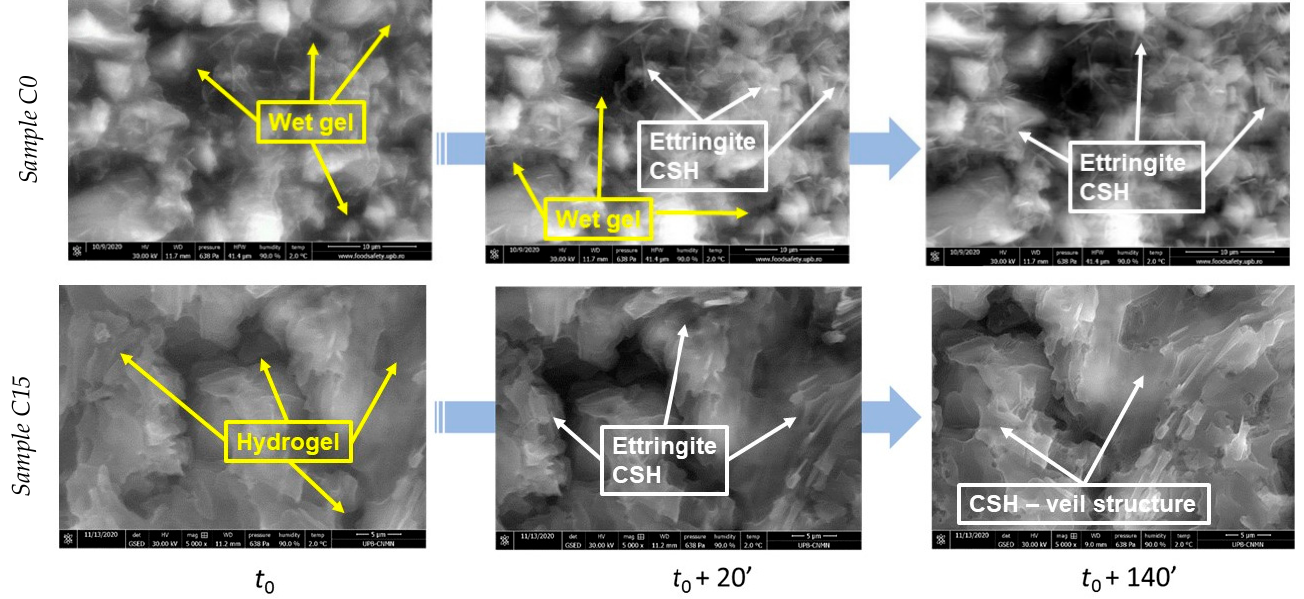
Figure 3. Scanning electron micrographs for C0 and C15 samples during hydration of the paste.